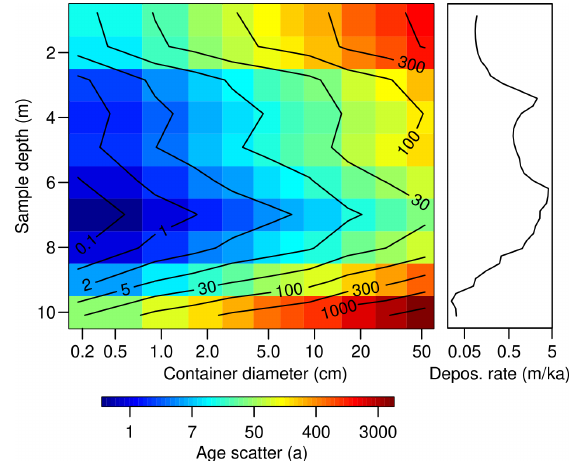
Figure 4. Effect of cylindric sample container size. Warmer colours indicate a higher age